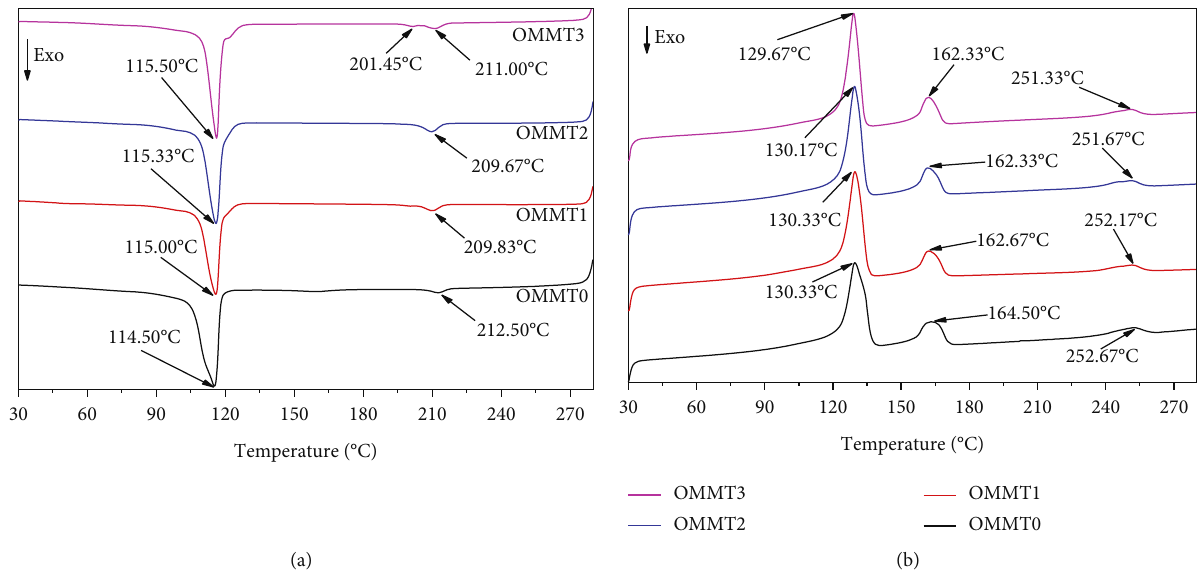
Figure 9: (a) The DSC curves of 3D-printed OMMT0, OMMT1, OMMT2, and OMMT3 composite specimens. (b) Melting temperature curves of 3D-printed OMMT0, OMMT1, OMMT2, and OMMT3